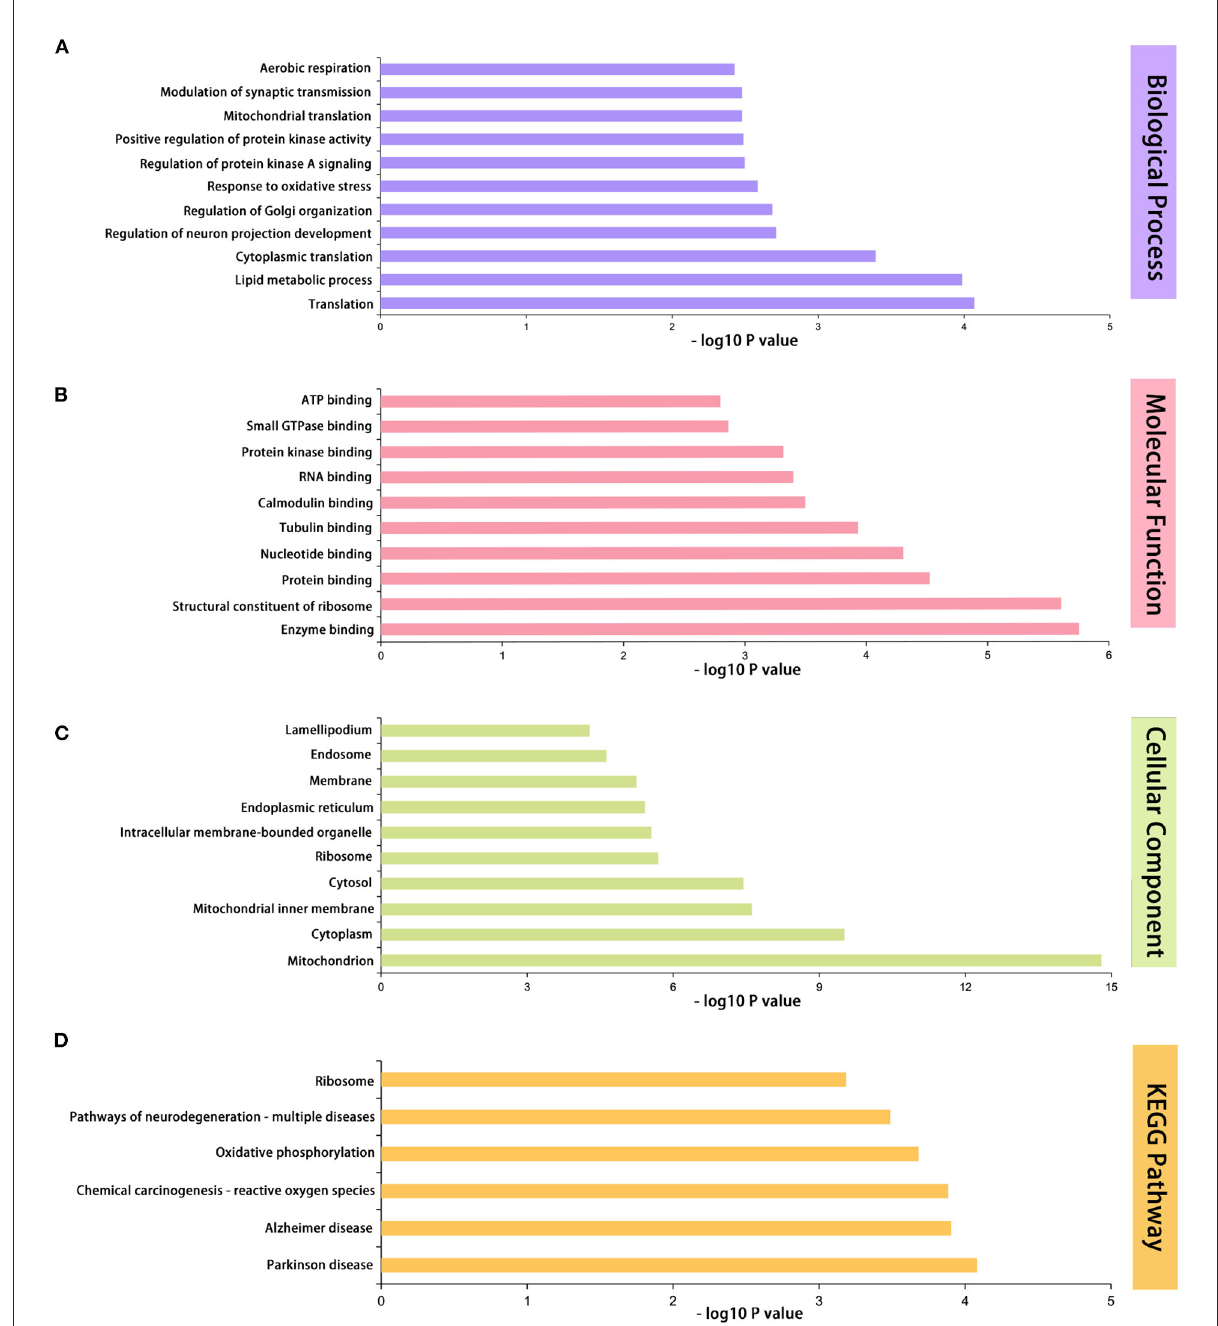
FIGURE4 GO and KEGG functional enrichment analyses of 433 differentially expressed proteins. (A) The first 11 enriched GO terms of biological process. (B) The first 10 enriched GO terms of molecular functions. (C) The first 10 enriched GO terms of cellular components. (D) Differentially expressed protein pathway enriched by KEGG pathway analysis. n = 5 mice/group. GO, Gene Ontology; KEGG, Kyoto Encyclopedia of Genes and Genomes.